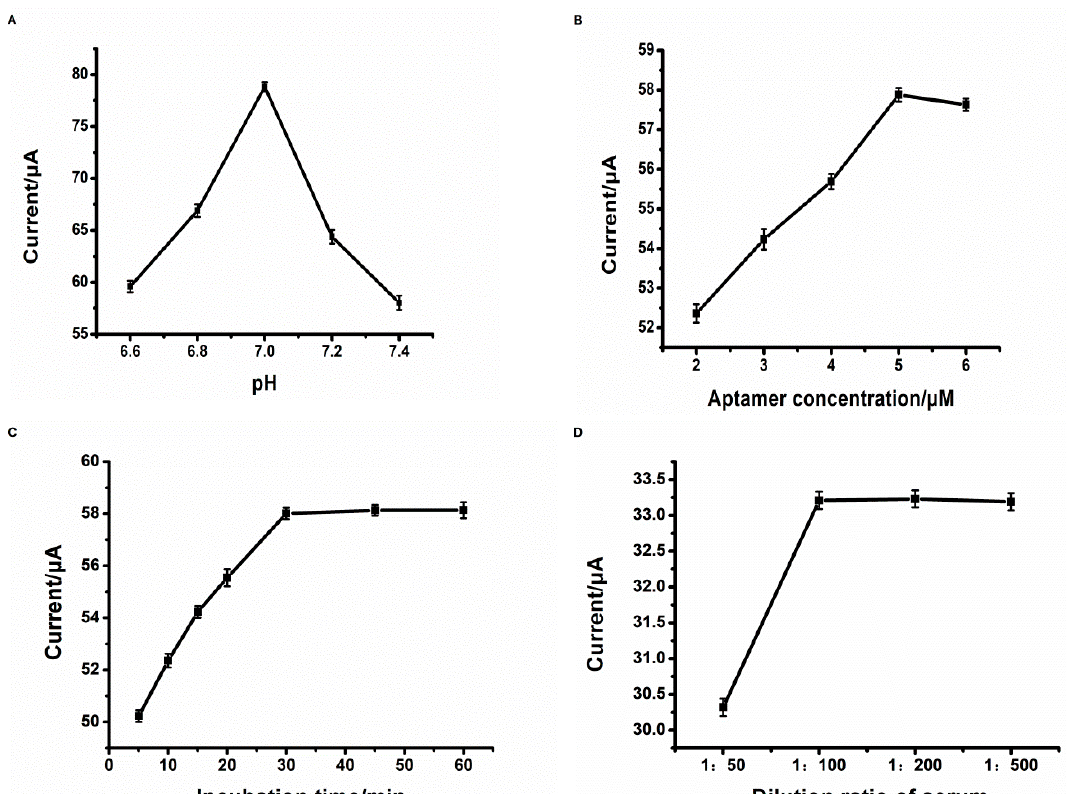
Figure 4. Optimization of experimental conditions for detection of tau381. pH value ( A ): 6.6, 6.8, 7.0, 7.2, and 7.4; aptamer concentration; ( B ): 2, 3, 4, 5, and 6 µ M; aptamer-tau381 incubating time; ( C ): 5, 10, 15, 20, 30, 45, and 60 min; dilution ratio of serum; ( D ): 1:50, 1:100, 1:200, and 1:500, respectively. The concentration of tau381 was 20 pM and the current signal was obtained by the DPV which was carried out in 0.1 M PBS (pH 7.0) from − 0.6 to 0.2